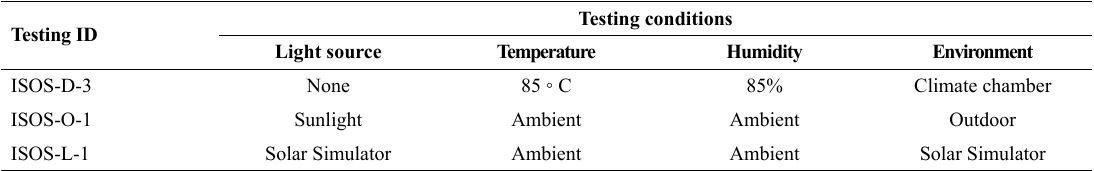
Table 2. ISOS protocols used for lifetime and stability testing of OSC.